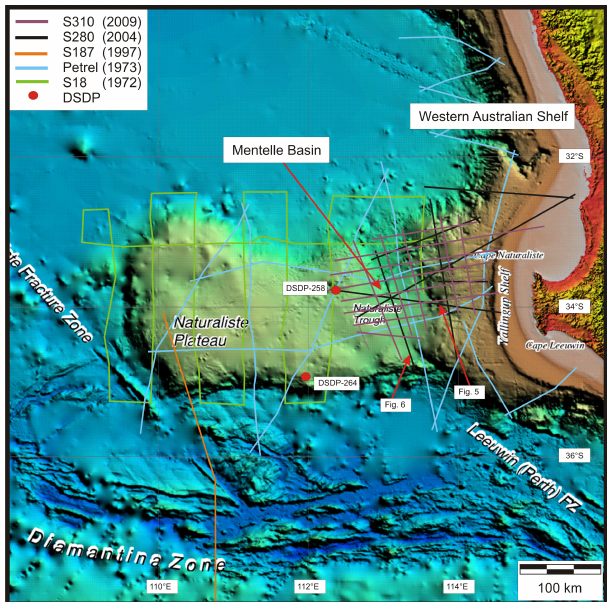
Fig. 3. Bathymetric map of the Mentelle Basin situated off- shore Cape Leeuwin. The positions of the 2-D seismic surveys together with borehole locations are shown (modified from Bor- rissova,